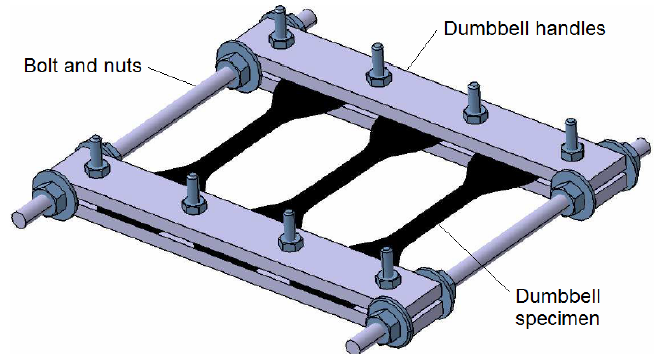
Figure 2. Specially-designed device for the immersion test of rubber specimens in the presence of uniaxial mechanical loading.